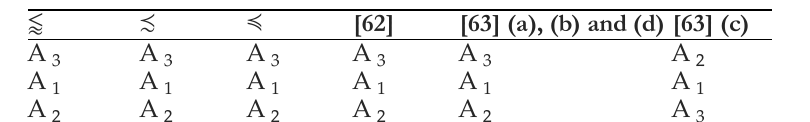
Table 6. Assesses of expert 𝐞